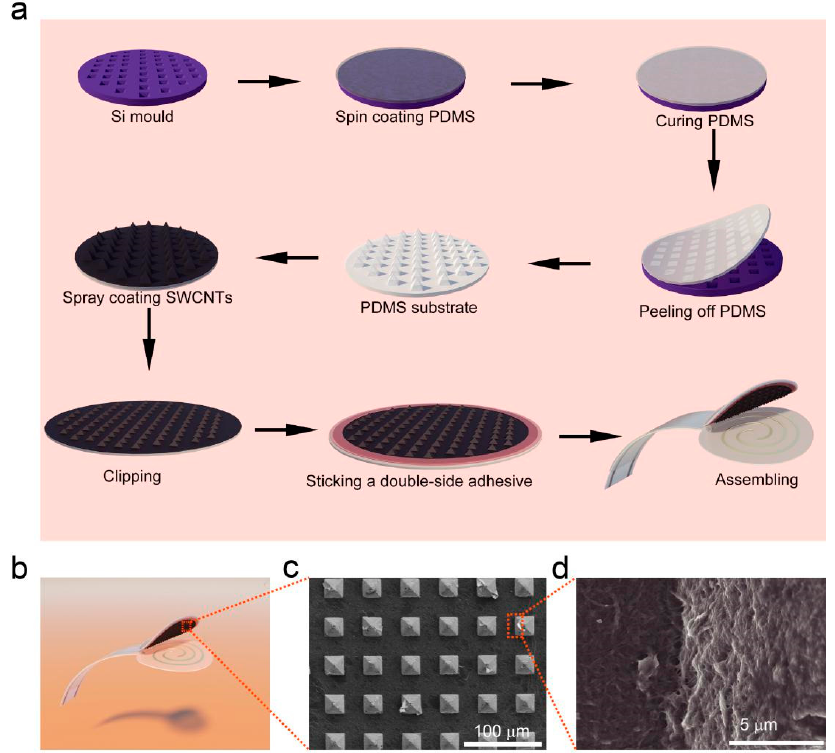
Figure 2. Fabrication and structure of the flexible pressure sensor. ( a ) Schematic of fabrication process